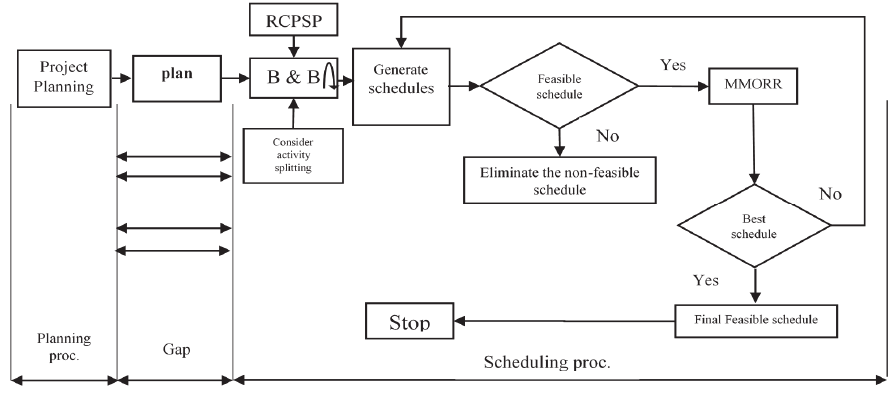
Fig. 1. The gap between project planning and